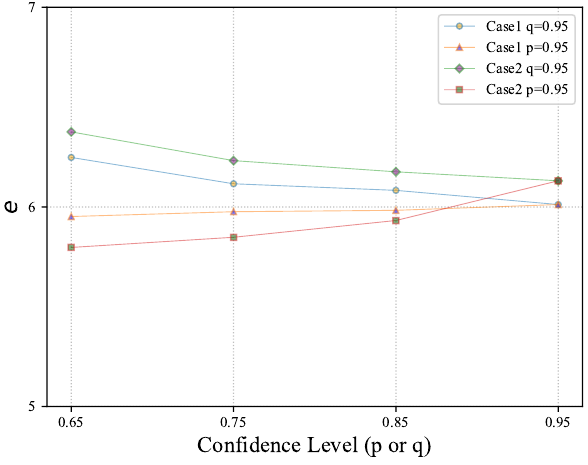
Figure 4. Sensitivity test on Model